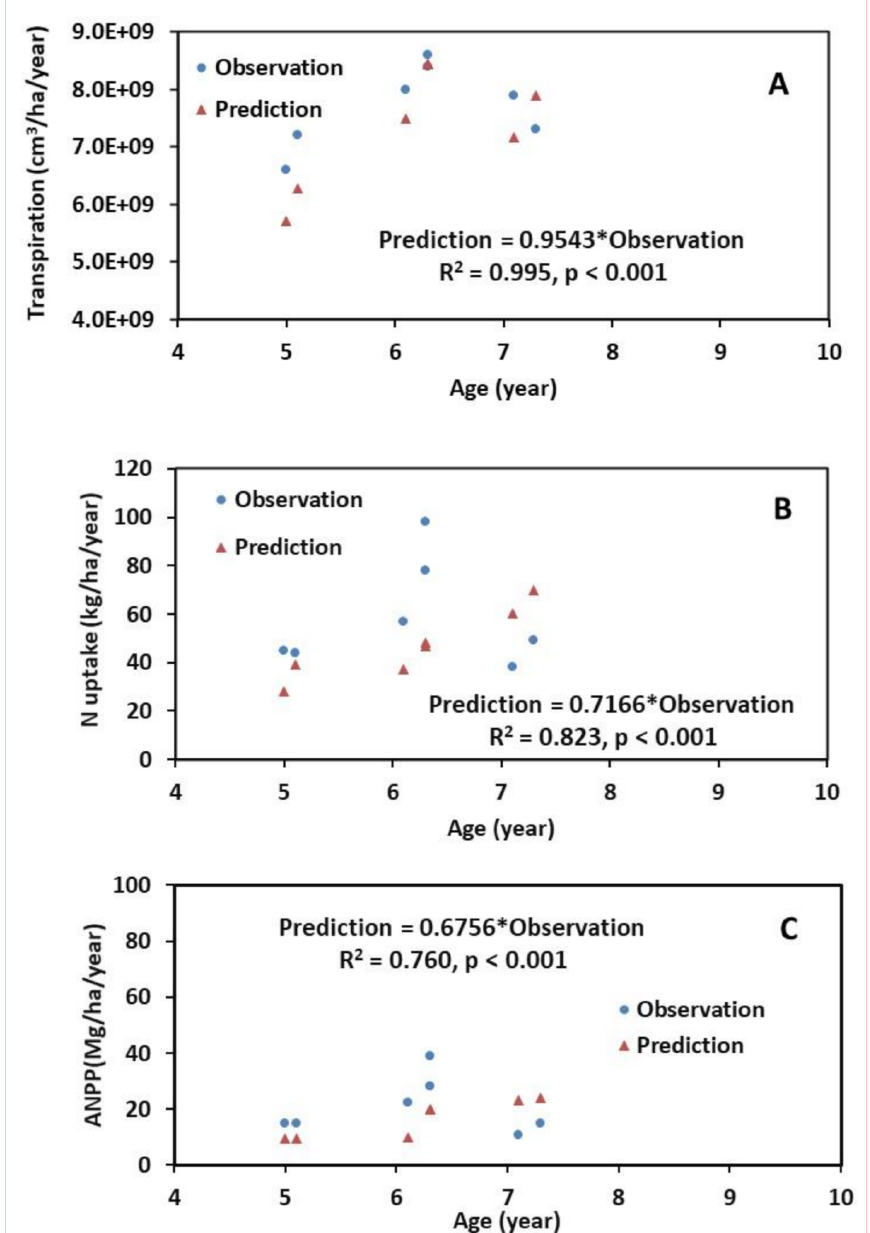
Figure 5. Comparison of model-predicted and field measured transpiration ( A ), N uptake ( B ), and ANPP ( C ) during the model